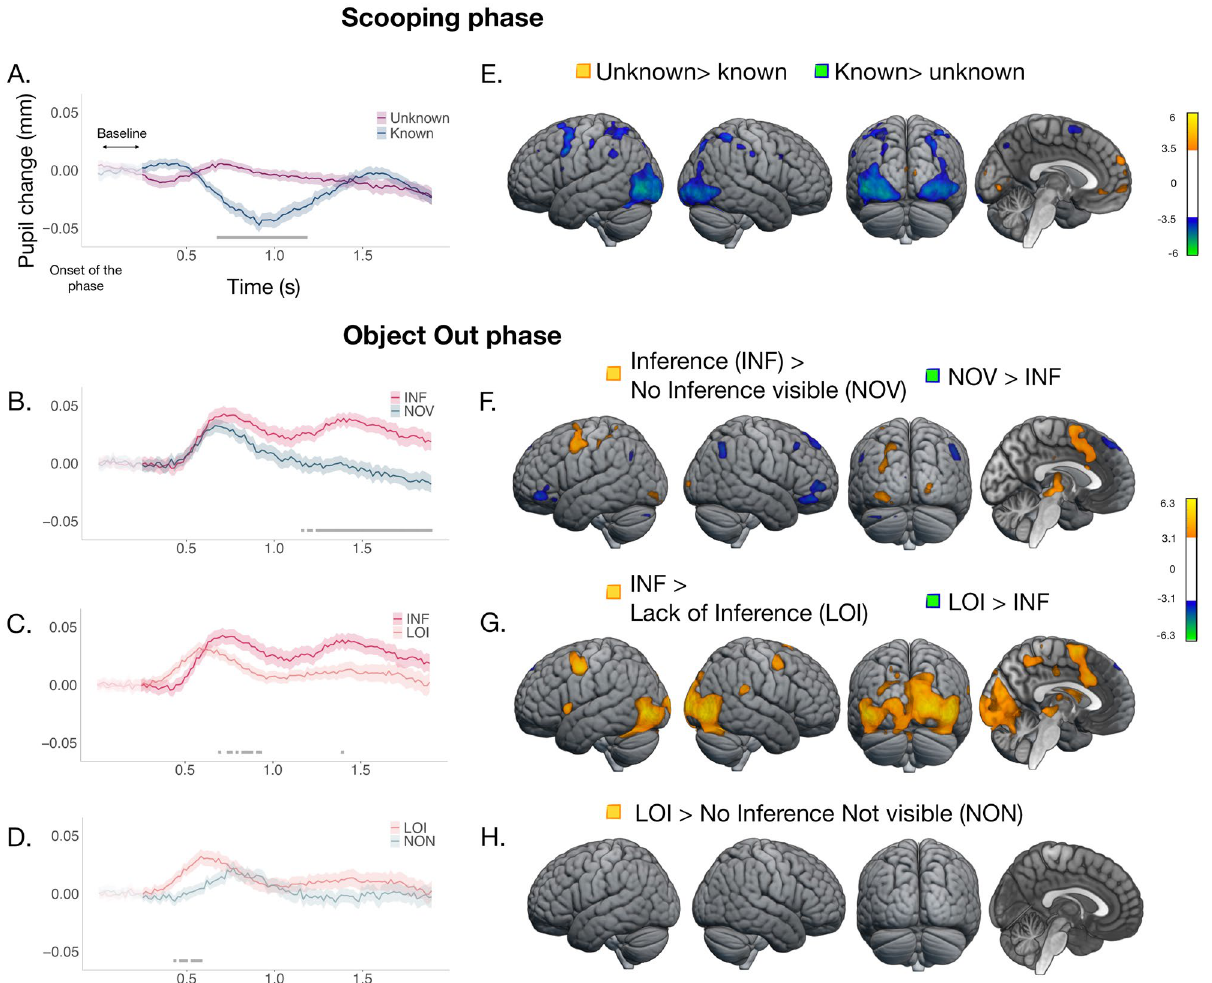
Figure 2. Pupil dilation (Experiment 1) and Brain activations (Experiment 2) during the Scooping and Object Out phases. At Scooping, one of two objects has entered the cup either in a visible (Known) or invisible (Unknown) manner. At Object Out, the object behind the occluder exits. Depending on the condition, the exit may be informative to deduce the identity of the object inside the cup (INF: inference needed; LOI: no inference can be drawn: NOV and NON: no inference needed). ( A–D ) Temporal course of the mean pupil dilation (SEM) from baseline. Grey horizontal lines indicate areas of effect identified by permutation tests, ( B – D ) additionally Bonferroni-corrected. ( A ) Unknown (purple) and Known (dark blue) conditions. Pupil size reduced in the Known compared to the Unknown condition, indicating sustained cognitive effort due to possible logical processing in the latter. ( B ) INF (red) and NOV (blue stone) conditions; ( C ) INF and LOI (light red) conditions; and ( D ) LOI and NON (light blue) conditions. Pupil dilation was higher when a logical inference was required to identify the object in the cup, or when an unknown representation had to be maintained, compared to the conditions requiring no inference ( B , D respectively). Likewise, a logical inference elicited a higher pupil dilation compared to LOI, another condition with logical valence ( C ). ( E–H ) Whole brain views (lateral left and right, posterior and medial) of the main brain areas responding to the ( E ) Unknown (orange/yellow) and Known (blue/green) conditions (T > 3.47); to the INF condition (orange/yellow) contrasted to ( F ) the NOV (blue/green) and ( G ) the LOI (blue/green) conditions; and to the LOI contrasted to the NON condition ( H ) (T > 3.09). See Supplementary Table S1−S6 for other active